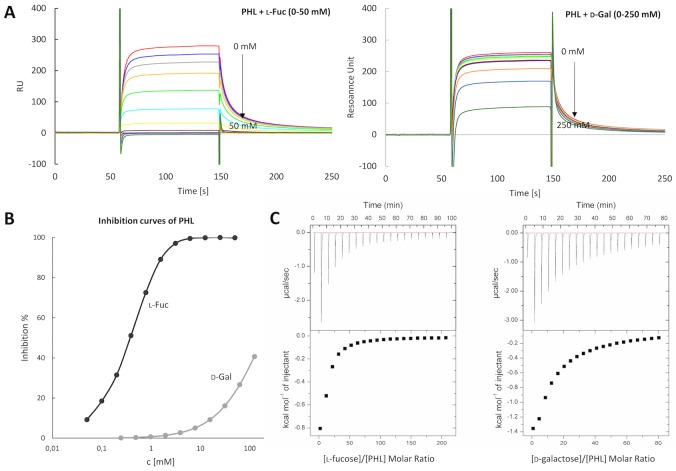
Determination of carbohydrate specificity/affinity of PHL towards l-fucose and d-galactose.(A) SPR sensorgrams (differential curves) displaying PHL binding (0.25 μM) to CM5 sensor chip with immobilized l-fucoside in the presence of competing saccharides. Response decreases with increasing concentration of the inhibitor–l-fucose (0–50 mM), d-galactose (0–250 mM). (B) A logarithmic plot of inhibition curves calculated from SPR measurements (C) ITC curves of PHL (50 μM) titration by l-fucose (20 mM) and d-galactose (50 mM). 20 injections of 2.0 μl of sugars were added every 240 s to a PHL-containing cell. Lower plots show the total heat released as a function of total ligand concentration for the titration shown in the upper panels.